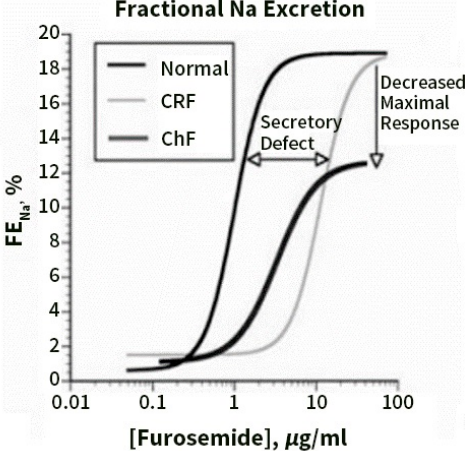
Figure 3. Dose–response curves for loop diuretics illustrate the fractional Na excretion (FENa) as a function of loop diuretic urine concentration. Compared with normal patients, patients with chronic renal failure (CRF) show a rightward shift in the curve, owing to impaired diuretic secretion. The maximal response is preserved when expressed as FENa, but not when expressed as absolute Na excretion. Patients with congestive heart failure (CHF) demonstrate a rightward and downward shift, even when the response is expressed as FENa, and thus are relatively diuretic resistant. Reprinted with permission from Ref. [67]. 2022, Karger.